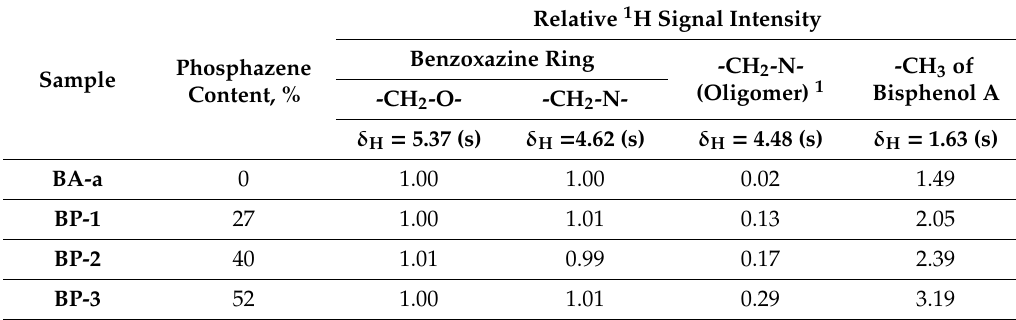
Table 2. Results of 1 H NMR spectroscopy of BA-a and phosphazene-containing benzoxazines.